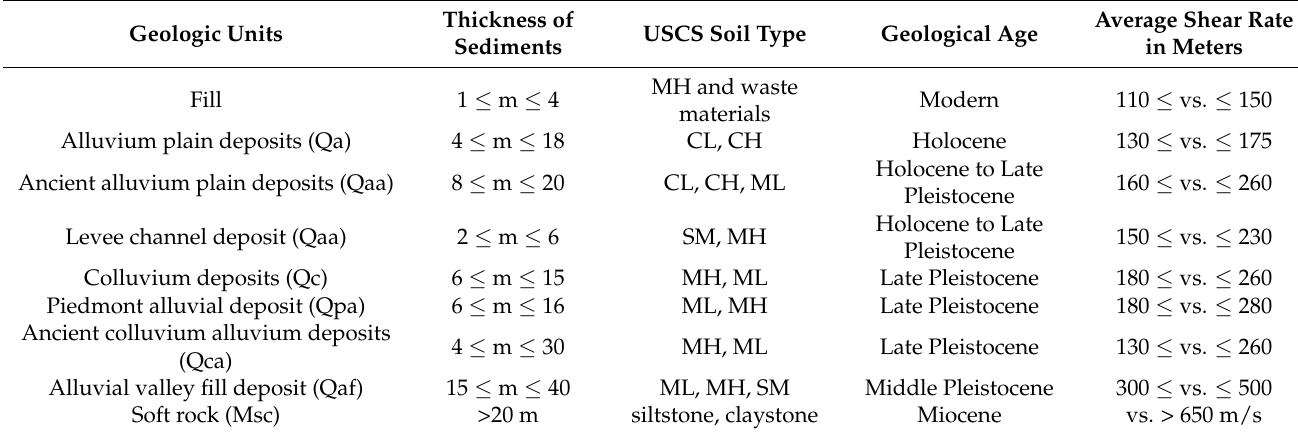
Table 3. Classification of the geological materials of the seven present Quaternary units and the one Miocene (Tosagua) unit of Portoviejo